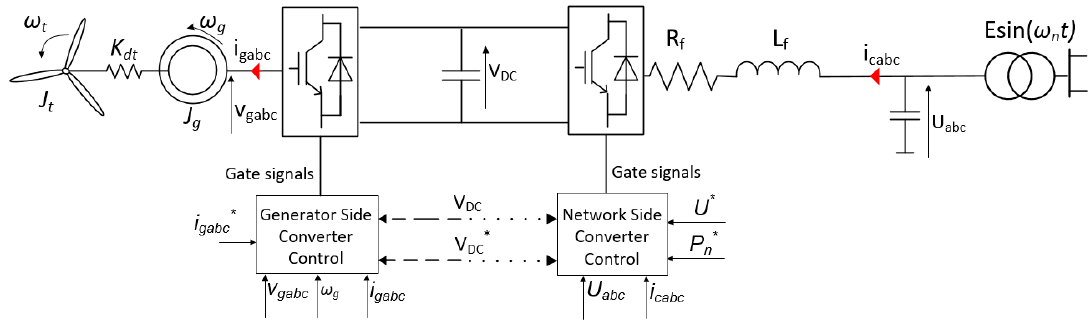
Figure 1. Full model overview.